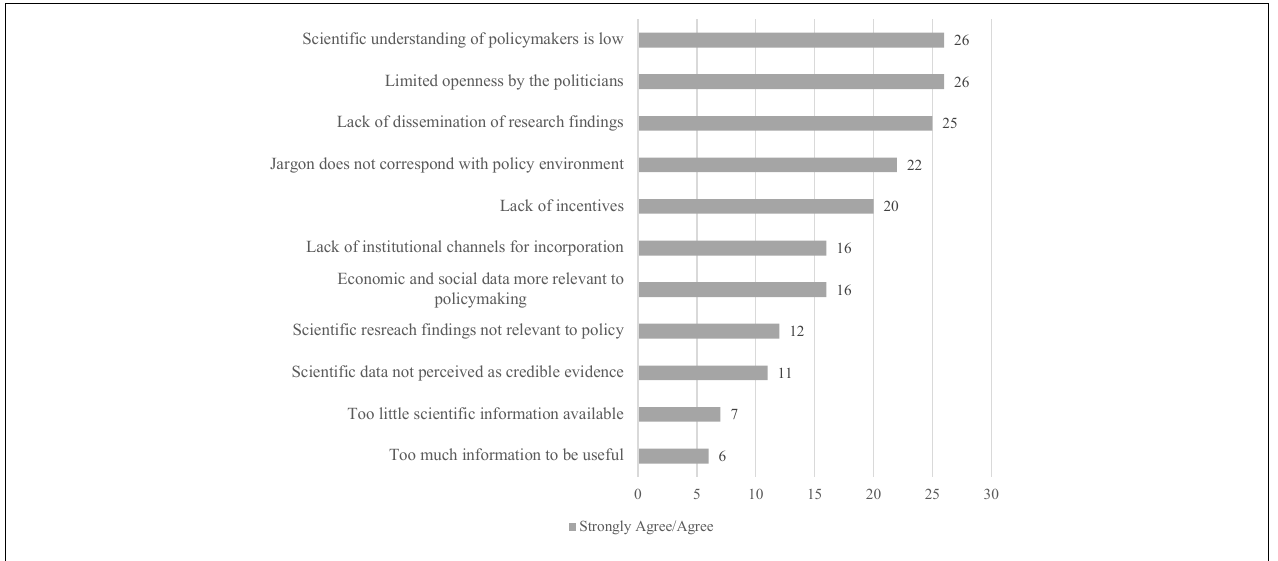
FIGURE 9 | Obstacles to the uptake of research information in the development of policymaking.